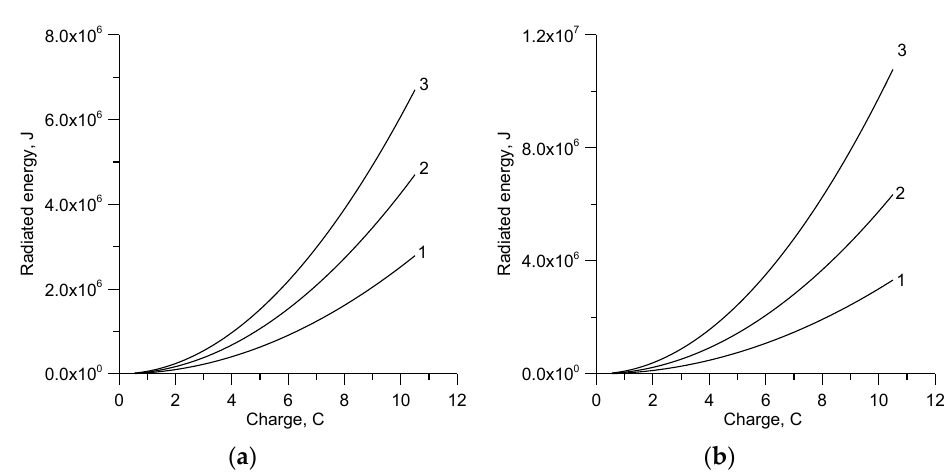
Figure 6. The total energy radiated by the current pulse as a function of the associated charge. The results are shown for three speeds of propagation. Plot ( a ) corresponds to half sine waveform and plot; ( b ) corresponding to exponential current. (1) u = 1.0 × 10 8 m/s; (2) u = 1.5 × 10 8 m/s; (3) u = 2.0 × 10 8 m/s.